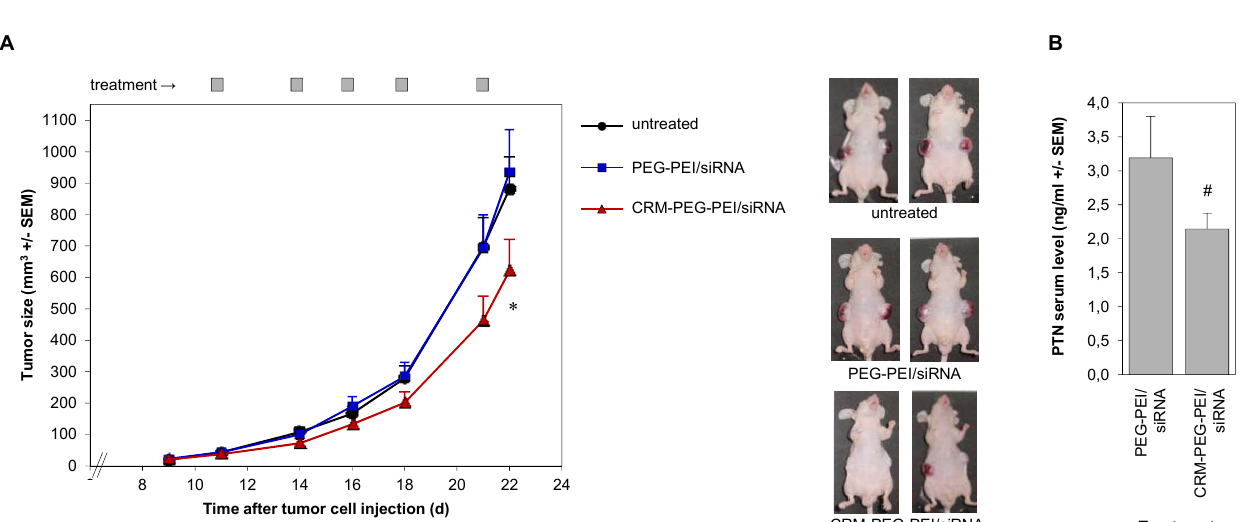
Figure 6. CRM197-PEG-PEI-mediated anti-tumor effects of CRM197-PEG-PEI/siRNA complexes targeting pleiotrophin (PTN). ( A ) After establishment of s.c. U87 glioblastoma xenografts, athymic nude mice were treated by intraperitoneal injection of PTN-specific CRM197-PEG-PEI/siRNA complexes (red triangles) or PEG-PEI/siRNA complexes (blue rectangles) at the time points indicated, or were left untreated (black circles). Left panel: quantitation of tumor sizes during the treatment (12 tumors per group; p < 0.02 between CRM-PEG-PEI/siRNA and PEG-PEI/siRNA or CRM-PEG-PEI/siRNA and untreated, respectively); right panel: pictures of representative mice from each group upon termination of the experiment. ( B ) PTN serum levels after termination of the experiment, as determined by ELISA (serum of six mice per